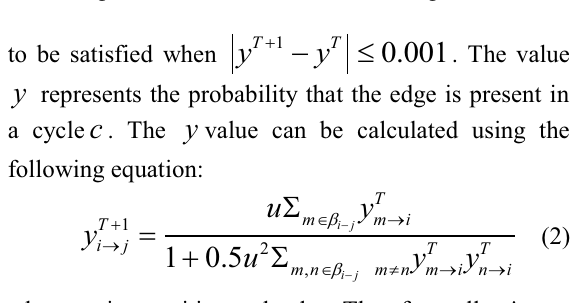
Figure 1. Pseudo code for the Exact